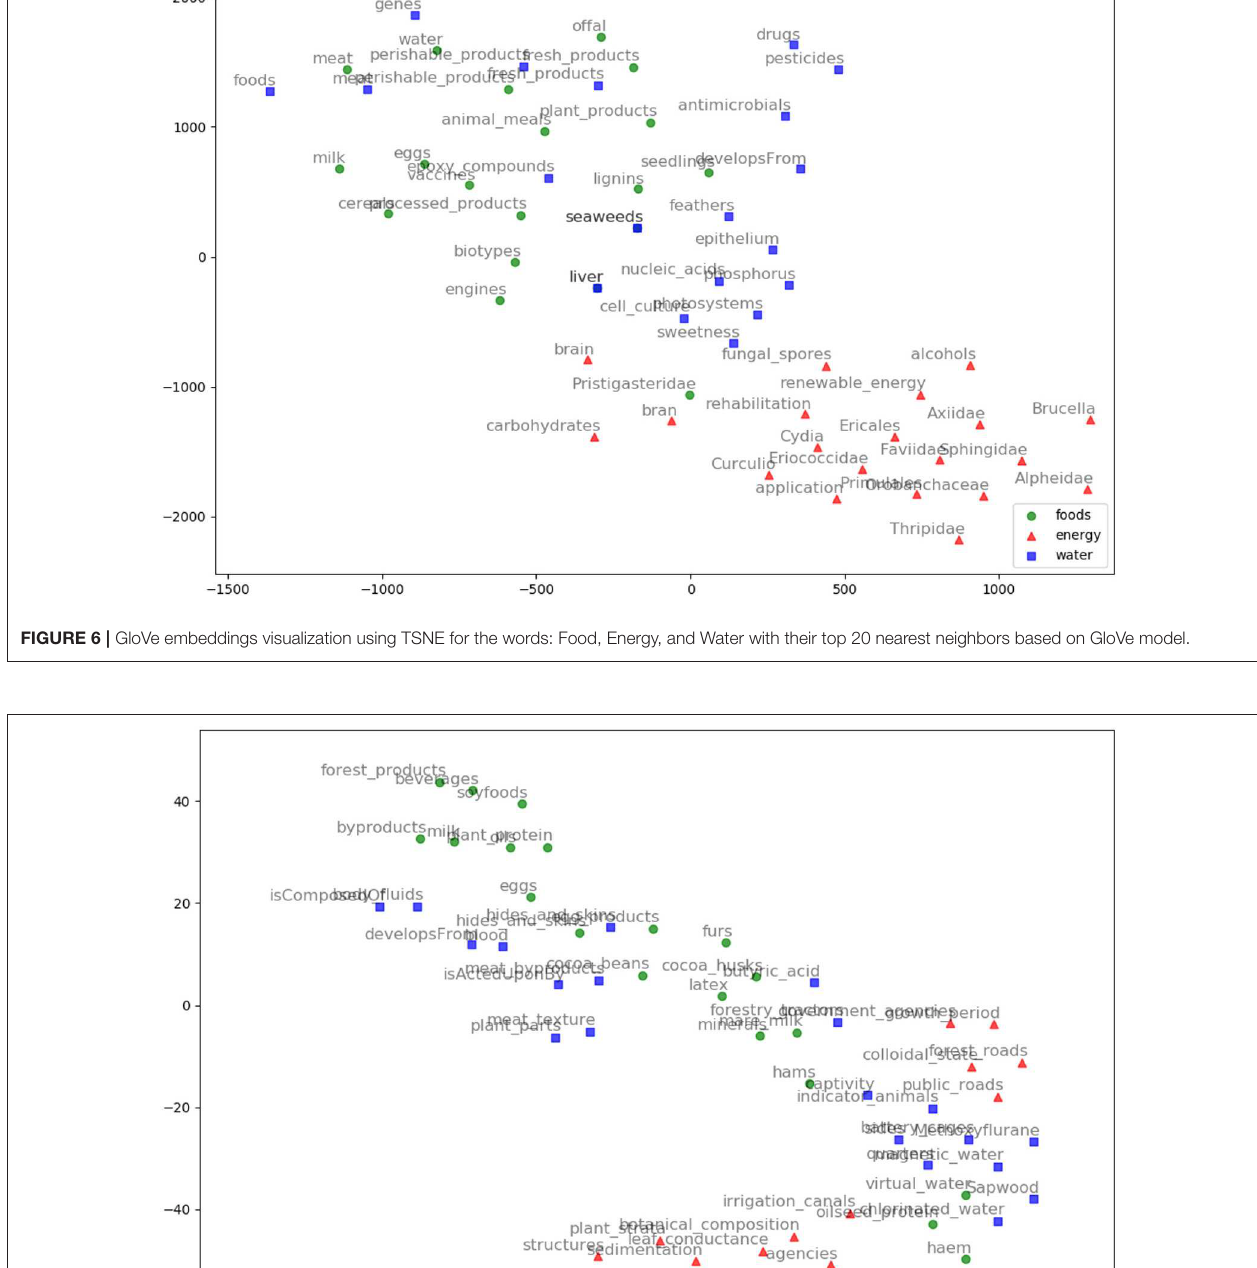
Frontiers in Big Data |